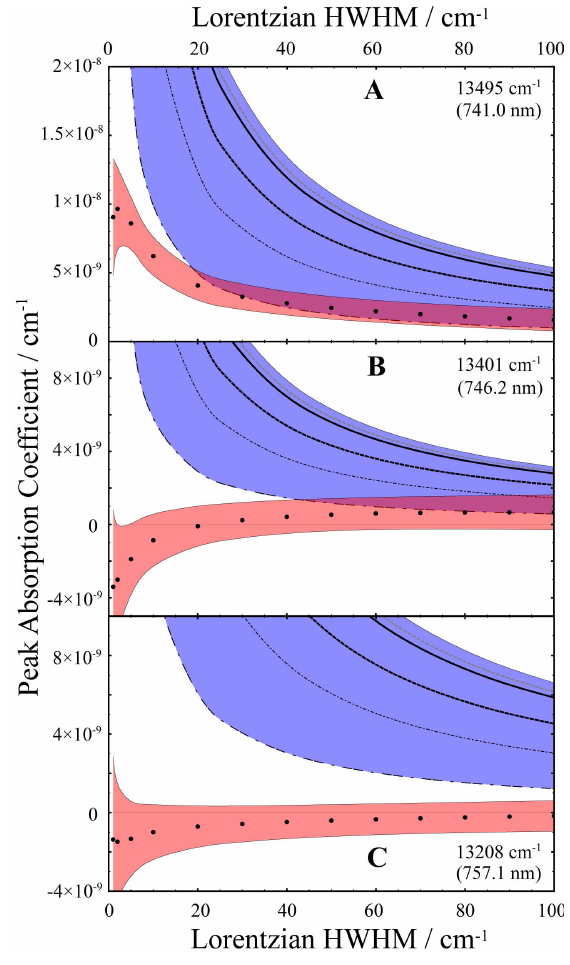
Fig. 8. Upper limits on any dimer signal remaining in the BBCRDS residual spectrum. Panel A: The peak intensity (black dots) of Lorentzian functions fitted to the BBCRDS residual spectrum shown previously in Fig. 7. The Lorentzian function is centred at 741.0nm (Low and Kjaergaard, 1999) and has a variable HWHM of γ =1, 2, 5, 10, 20... 100cm − 1 . The pink shaded area represents the 1 σ uncertainty in the fitted Lorentzian function’s peak inten- sity. The various solid and dashed lines in the blue envelope are HWHM-dependent absorption coefficients for the dimer calculated via Eq. (3) using the various values of K eq from the literature (same line types as Fig. 1) and the Hartree-Fock dimer line strength of Low and Kjaergaard (1999): see the main text. Panels B and C are analogous plots generated by fitting the BBCRDS residual spec- trum with Lorenztian functions centred at 746.2nm (Schofield and Kjaergaard, 2003) and 757.1nm (Schofield et al.,